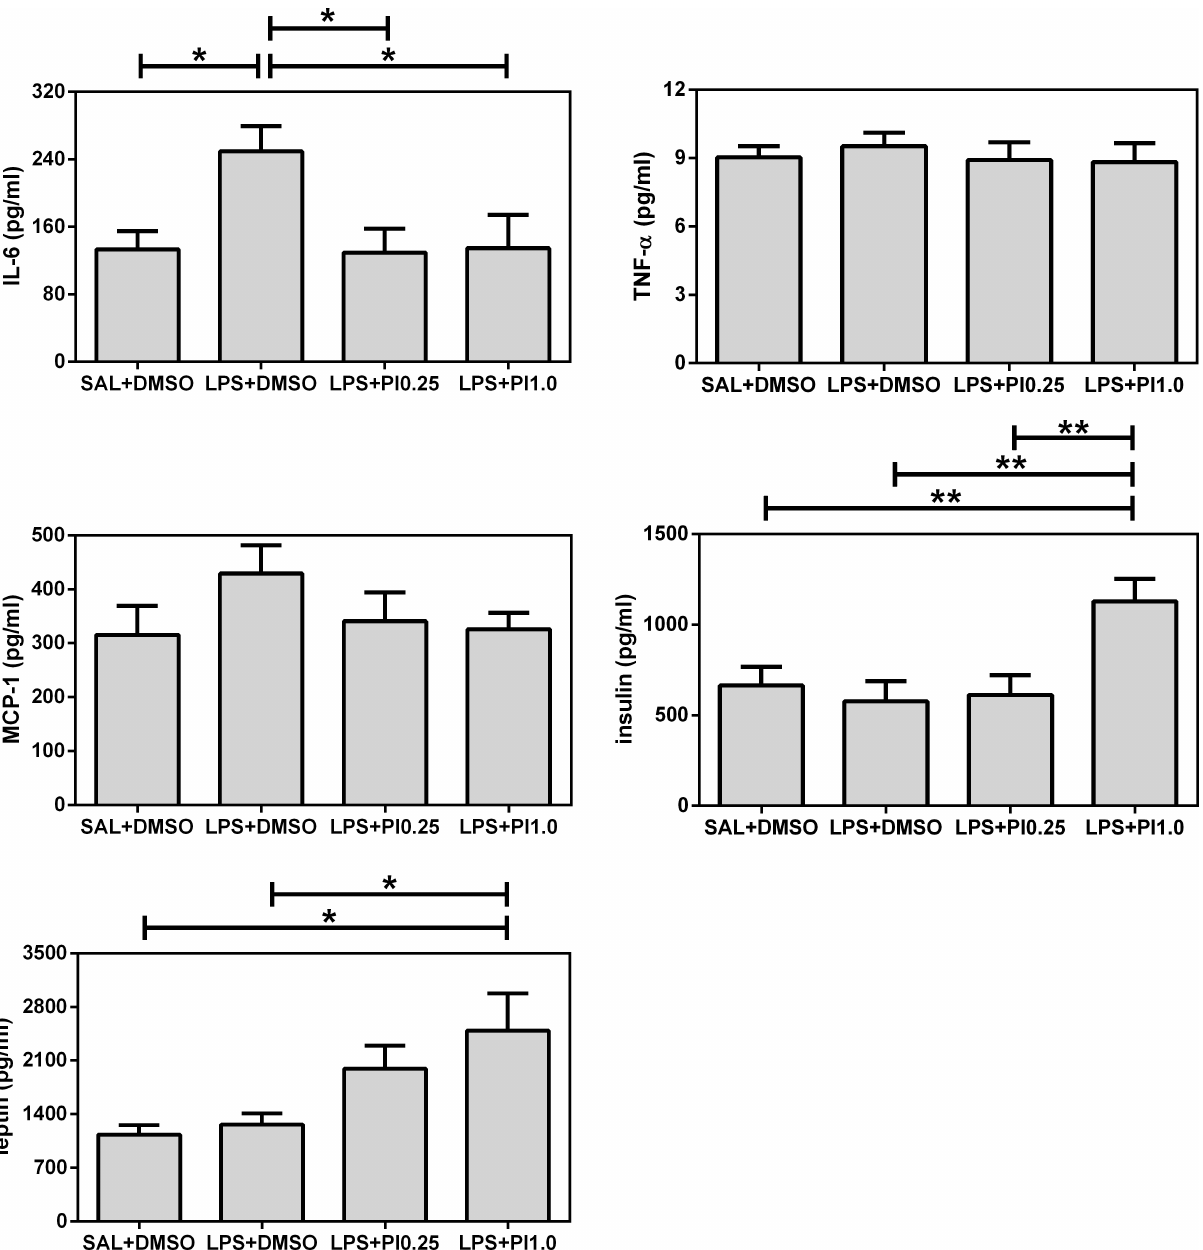
Fig 3. Plasma evaluations. The effects of prenatal LPS (100 μ g/kg at gestational day 9.5) and postnatal pioglitazone (0.25 and 1.0 mg/kg/day between postnatal days 21 and 29) exposures on IL-6, TNF-alpha, MCP-1, insulin, and leptin plasma levels in juvenile male rat offspring. SAL+DMSO, prenatal saline injection and postnatal daily DMSO injection; LPS+DMSO, prenatal LPS injection and postnatal daily DMSO injection; LPS+PI0.25, prenatal LPS injection and postnatal pioglitazone 0.25 mg/kg/day; LPS+PI1.0, prenatal LPS injection and postnatal pioglitazone 1.0 mg/kg/day ( n = 8 rats/group). (cid:3) p < 0.05 and (cid:3)(cid:3) p < 0.01 (one-way ANOVA followed by the Newman-Keuls test). The data are expressed as the mean ± the SEM.